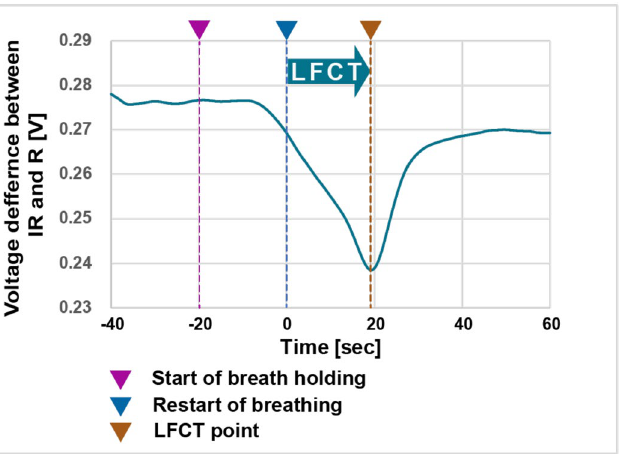
Figure 2. Typical trace during LFCT measurement. We asked the patients to hold their breath for 20 s. After breath holding, they restart their breathing according to the sign from the attending researcher. The time from the restart of breathing to the minimum value of the difference of R and IR (≈SpO 2 ) was defined as LFCT. In this case, LFCT was 19.2 s. LFCT: lung to finger circulation time, R: red light, IR: infrared